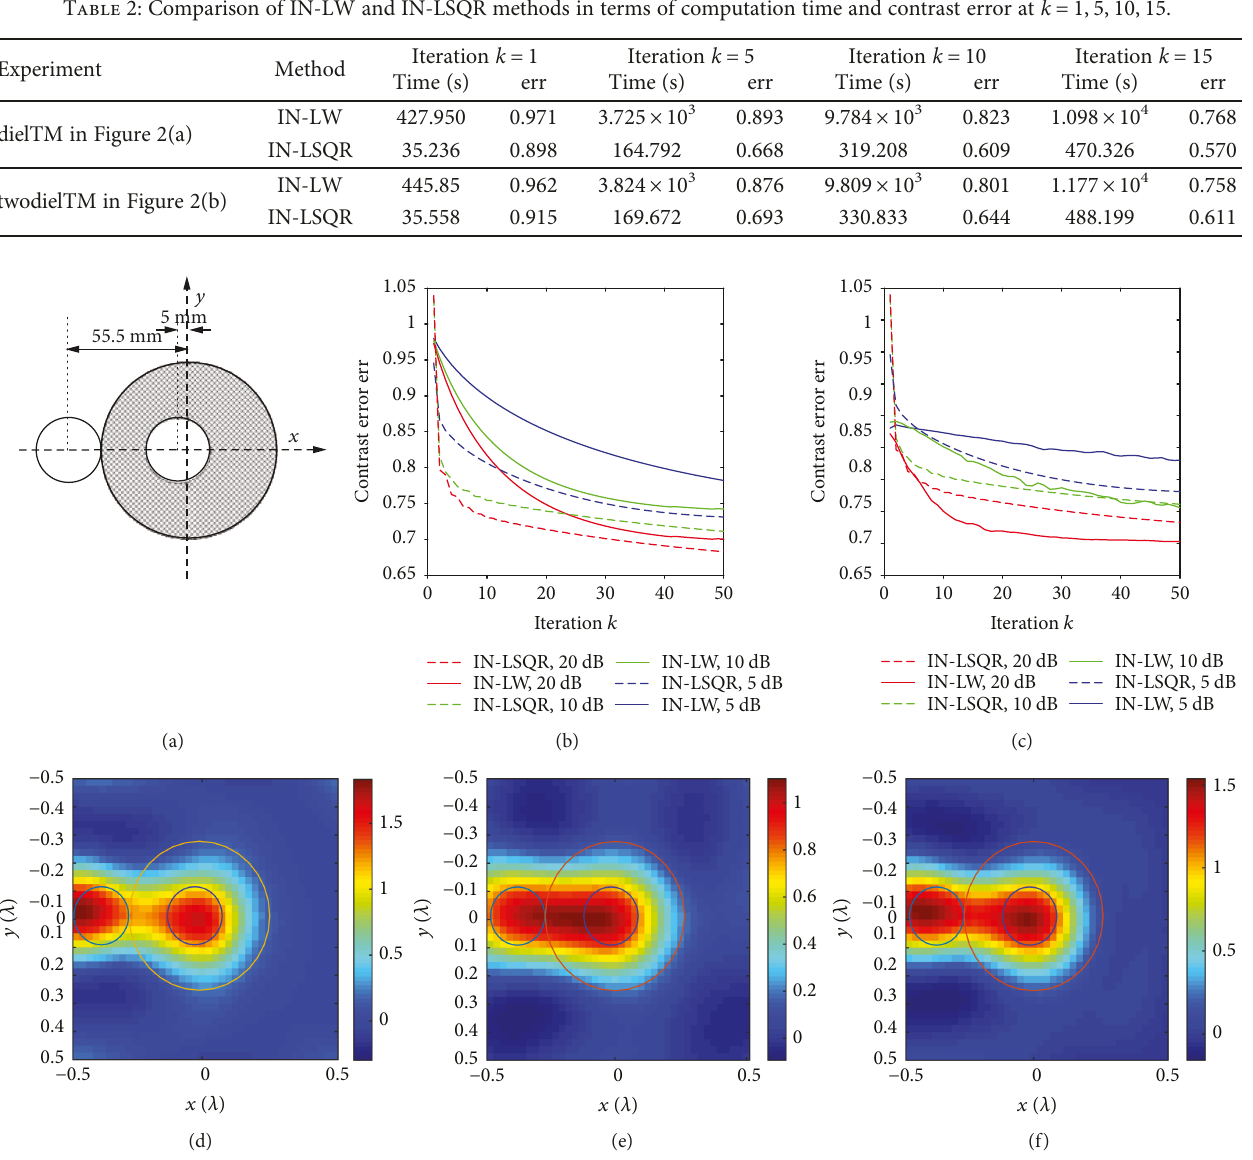
ff erent noise levels; (c) err k computed by IN-LSQR and IN-LW for di k